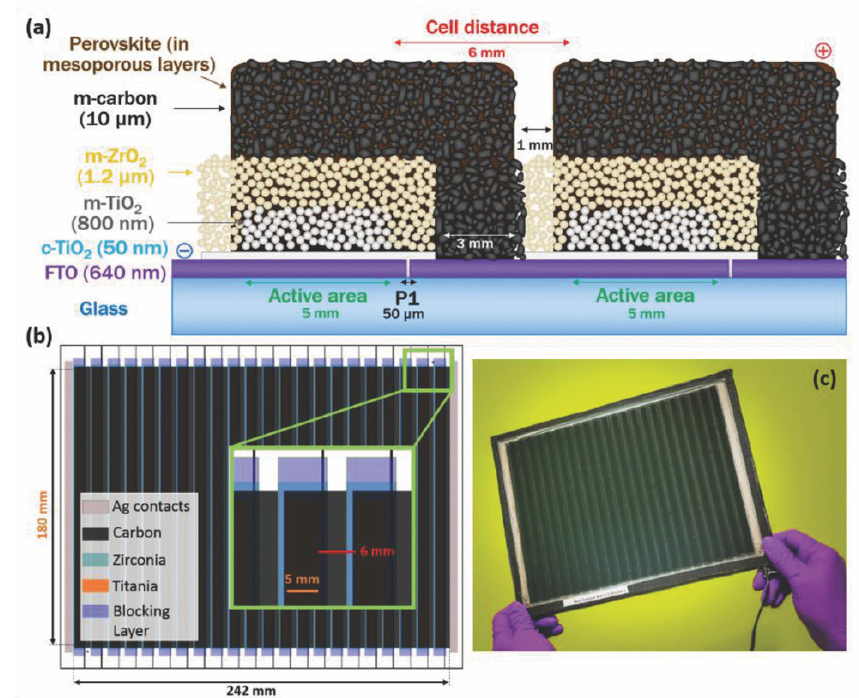
Figure 26. ( a ) Cross-section schematics of adjacent cells in the module with nominal thickness of each layer, highlighting the laser-etched FTO, patterning of TiO 2 blocking layer and the electrical vertical connection, ensured by the carbon back contact. ( b ) Module schematics, showing the different overlapping layers, the dimensions of the active area for both the individual single cell and the whole module as well as the distance between adjacent cells (inset). ( c ) Photo of a module; wires have been soldered to the silver painted busbars to provide more robust electrical contacts [103]. (Reproduced from Ref. [103], 10.1002/admt.201800156, with